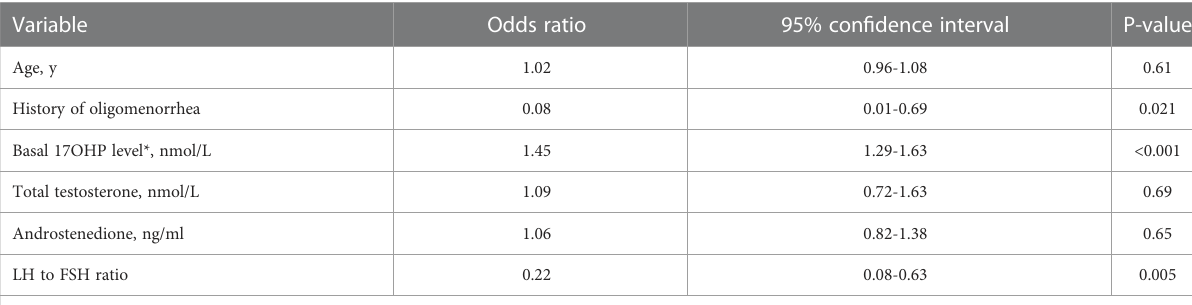
TABLE 5 Multivariate analysis for predictors of NCCAH among the RIA group.